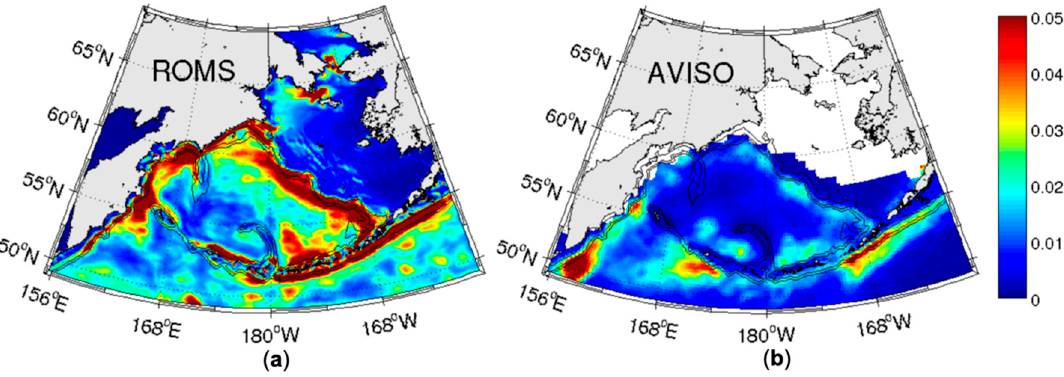
Figure 13. Mean eddy kinetic energy (EKE) (unit: m 2 / s 2 ) comparison between ( a ) the ROMS solution and ( b ) the AVISO data. The AVISO velocities are derived from gridded satellite altimetry-measured sea surface height-derived data, with the spatial resolution as 1 / 3 degree. EKE is calculated based on 12 year data (1993–2004). Contours denote water depths of 200 m, 500 m, 1000 m, and 2000 m. On the right panel, the white area in the ocean area is a sea ice covered area with no observations during the winter time, and the AVISO does not provide data for the area.